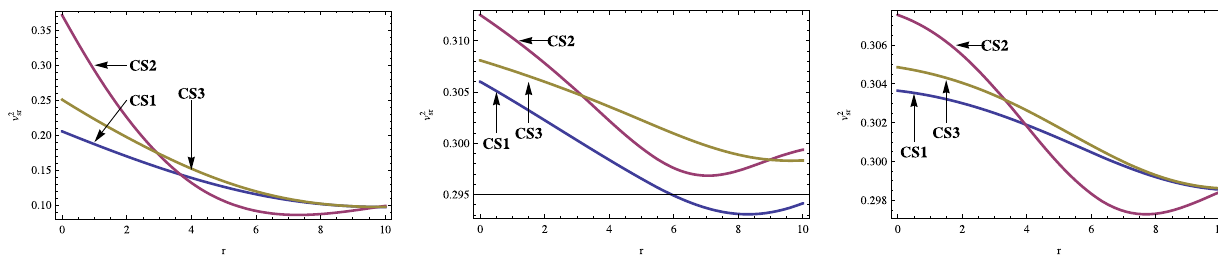
Fig. 13 Variations of v 2 sr versus r (km) with the numerical values of A , B and C from Tables 2, 3 and 4 respectively